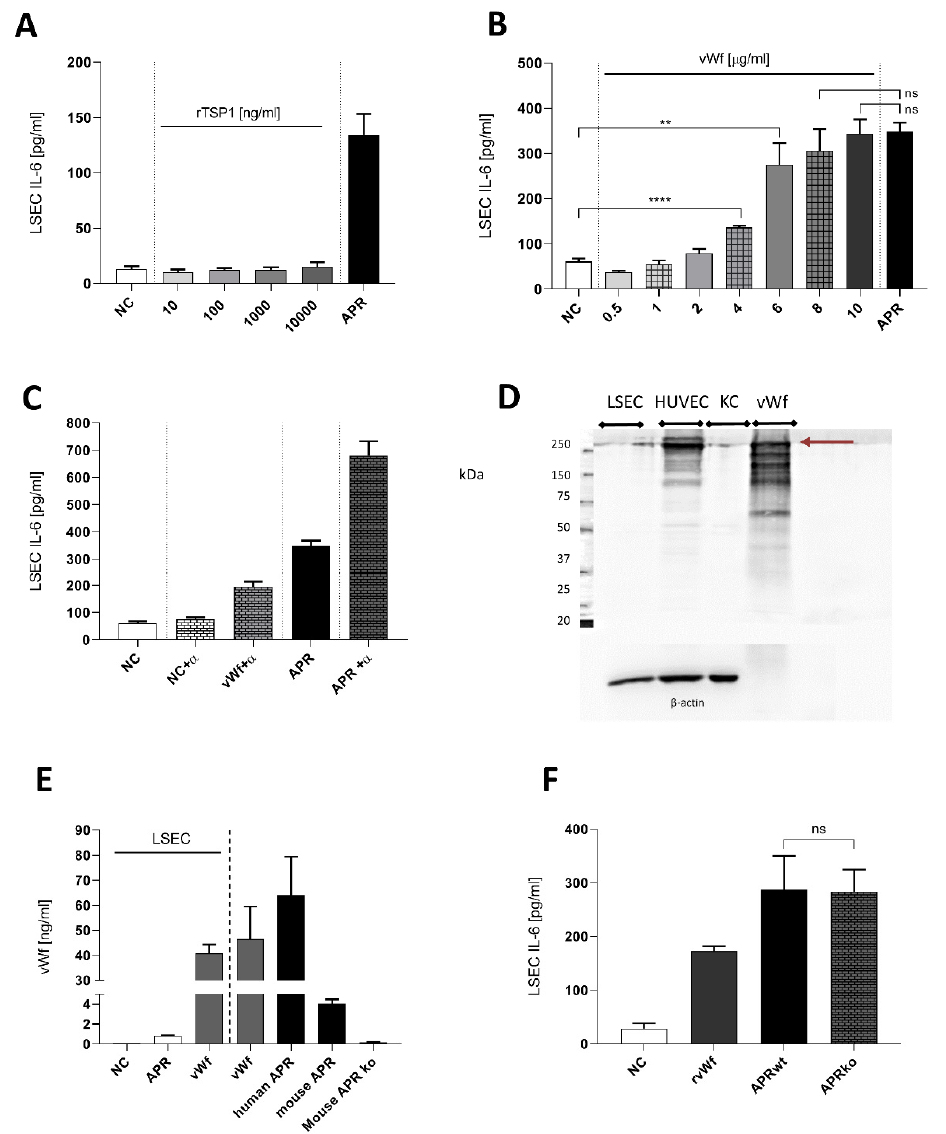
Figure 4. Characterization of soluble factors potentially inducing interleukin-6 secretion by liver sinusoidal endothelial cells. A : Concentrations of thrombospondin 1 (TSP1) from 10 to 1000 ng/mL did not stimulate IL-6 secretion by LSEC. NC: negative control, tyrode buffer. B : purified full-length human von Willebrand factor (vWF) was titrated on mouse LSEC. High concentrations of vWF resulted in an effect similar to human APR (positive control). NC: negative control, culture medium. C : Neutralization of human APR or 8 μ g/mL purified human vWF with anti-human vWF polyclonal antibody ( α ) 1/150. Combination of the antibody with APR or vWF resulted in an unexpected increase of IL-6 secretion by LSEC. NC: negative control, culture medium. D : Western blot for expression of vWF in LSEC, HUVEC, KC as a positive control, human purified full-length vWF (2.5 μ g). Contrarily, to HUVEC, LSEC and KC demonstrated low expression of vWF (250 kDa band, burgundy arrow). Purified full-length vWF exhibited several unspecific bands that were similar to HUVEC. Loading was controlled with β -actin. 7.5% acrylamide gel. n = 1 E : Presence of mouse vWF